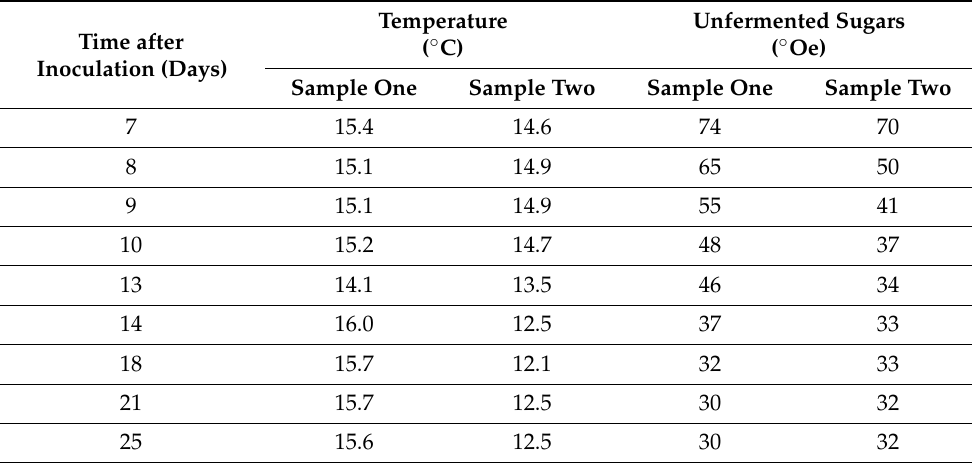
Table 2. The temperatures and fermentation course during production of Graševina wine. Temperature Unfermented Sugars Time after ( ◦ C) ( ◦ Oe) Inoculation (Days) Sample One Sample Two Sample One Sample